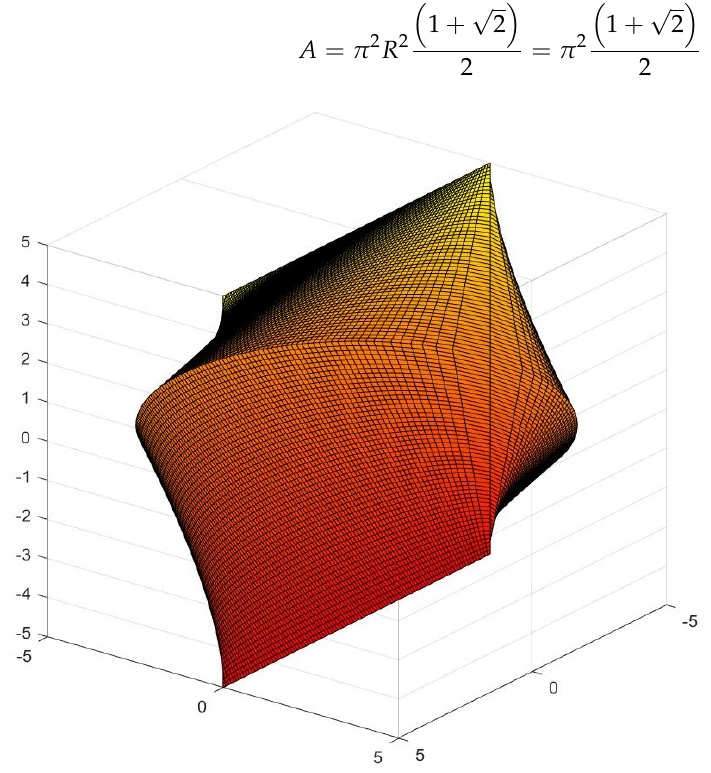
Figure 3. Depiction of the Antisphera for R = 5. View from below.